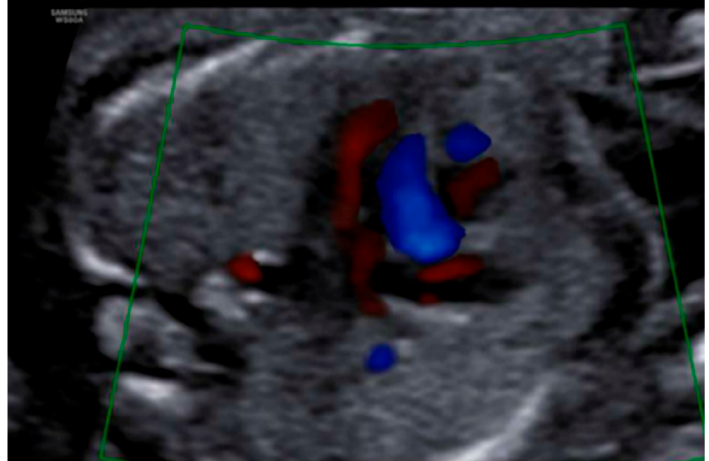
Figure 8. Mild deviation of the cardiac axis to the left.